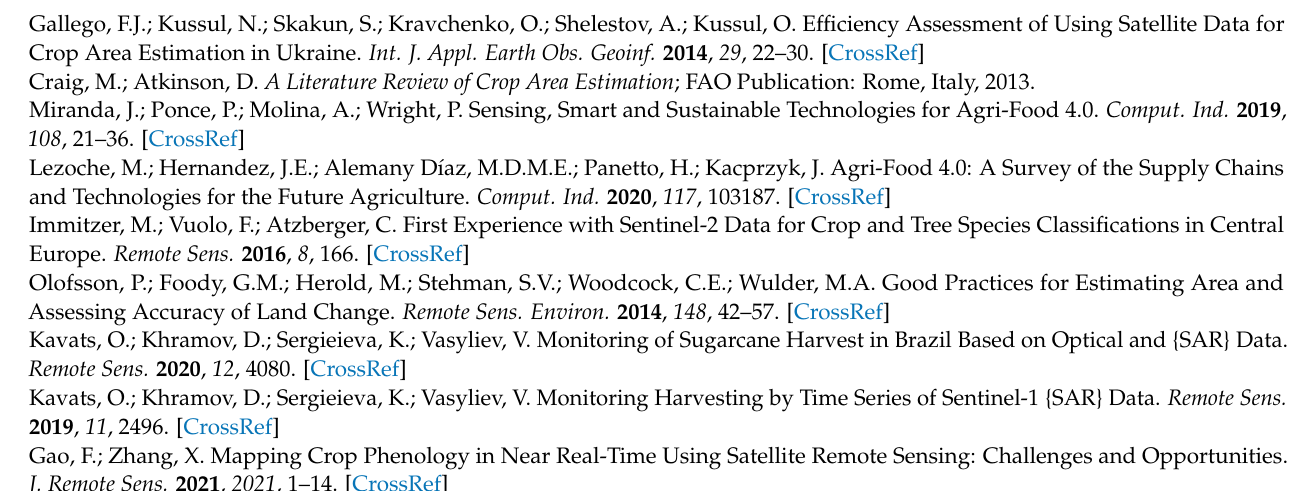
G-Mean achieved with